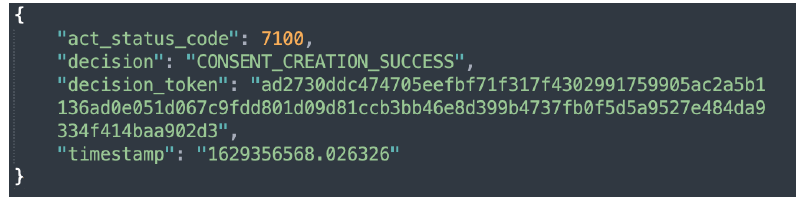
Figure 10. A snapshot of the consent creation